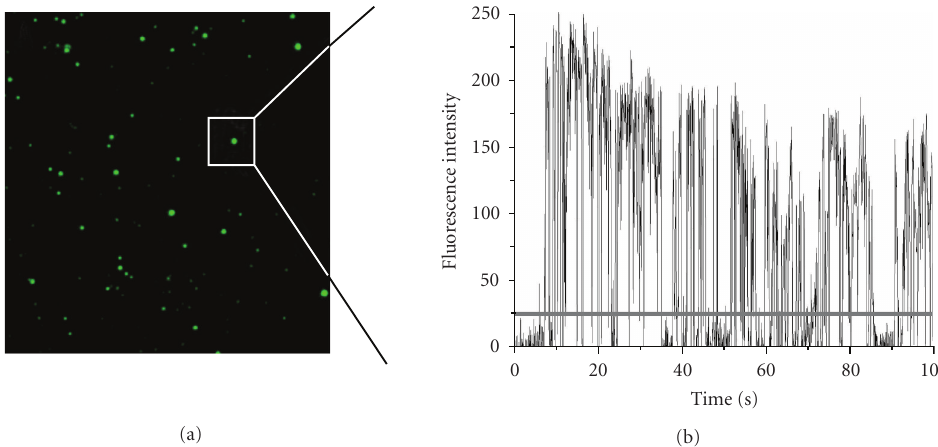
Figure 6: Evaluation of QD blinking. (a) Typical image of immobilized QDs. Due to their di ff erent brightness, some spots appear larger than others. Single QDs are identified by the size of their point spread function and selected for subsequent analysis. Image size is 40 × 40 μ m 2 . (b) Typical intensity trace of a single QD under continuous excitation. The grey line indicates an arbitrary threshold used to separate on-events from o ff -events. The threshold is usually set to 2–3 standard deviations above the background noise level, which is determined from nearby pixels containing no QD.